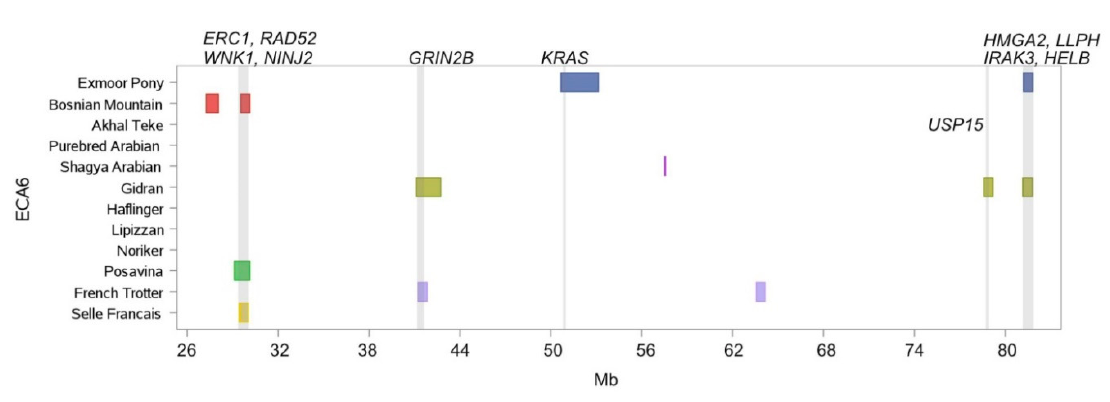
Figure 7. ROH islands on ECA6 between 26 Mb and 80 Mb. Location and length of ROH islands (shared by more than 50% of individuals per breed) per breed are illustrated as horizontal boxes, location of genes of specific interest are indicated as vertical lines.